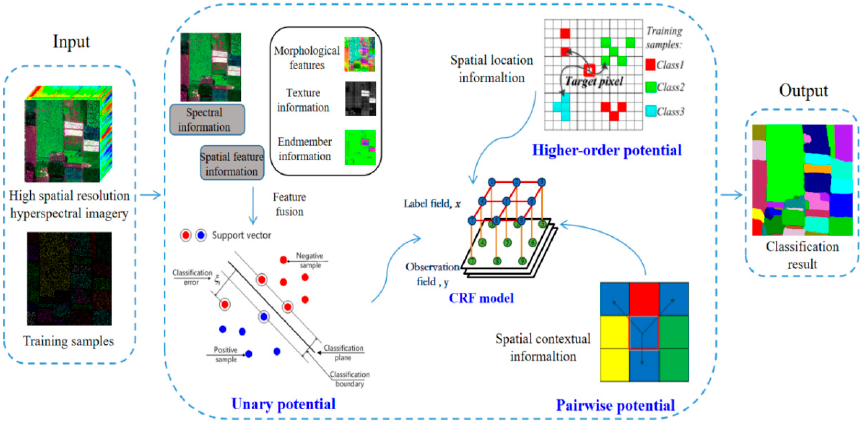
Figure 2. Flowchart of the spectral-spatial-location fusion based on conditional random fields (SSFL-CRF) method.